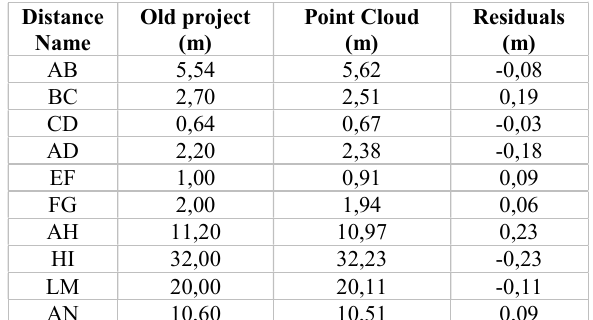
Figure 9. Insertion of distance for scaling the point cloud To validate the accuracy of the results, known distances were extracted from old design drawings and compared with the obtained point cloud, as shown in the previous images. The distance AL (16,0 m) was used to scale the model and chosen compared with the old ones.